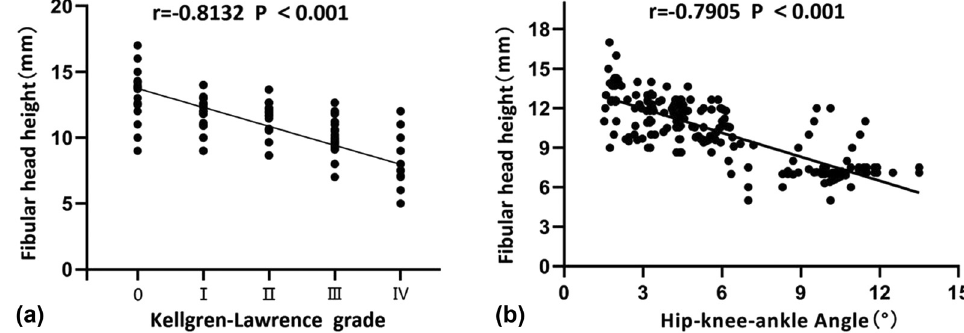
Figure 2: Correlation between fi bular head height and knee joint severity ( a ) and varus deformity ( b )